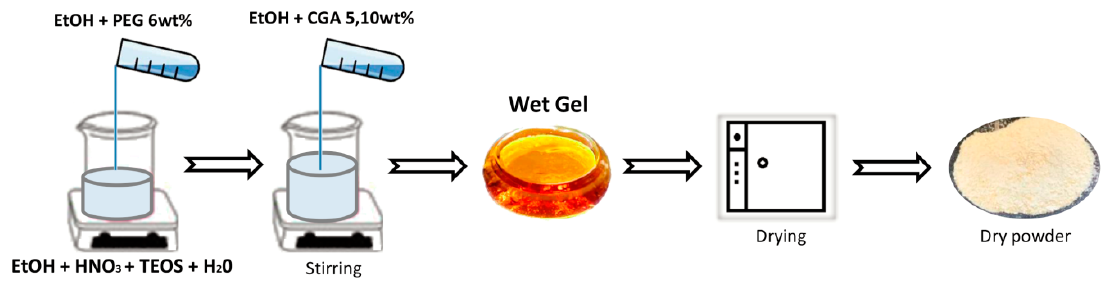
Figure 9. Flowchart of the sol-gel procedure used.